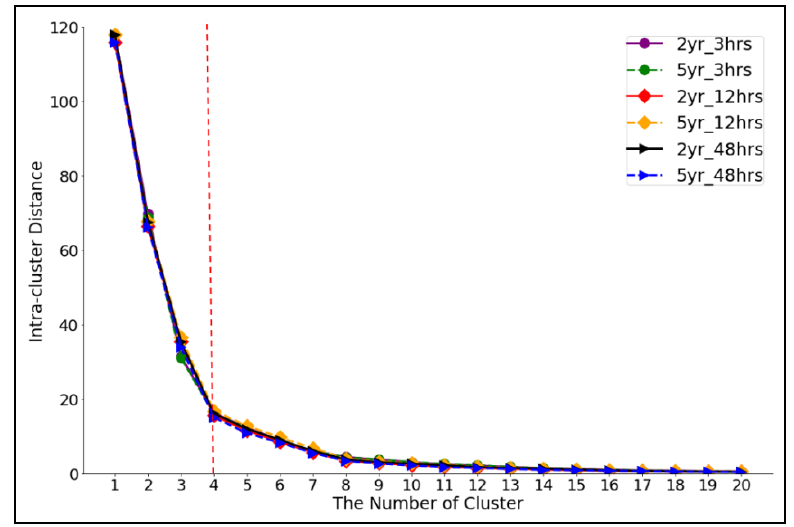
Figure 10. Cluster Intra-distance for comparing the effects of rainfall duration and return period on the performance of K-means and Spectral model (elbow point is the cross between the red dash-line and curves) under 6 synthetic rainfall scenarios (‘yr’ represents year while ‘hrs’ stands for h).